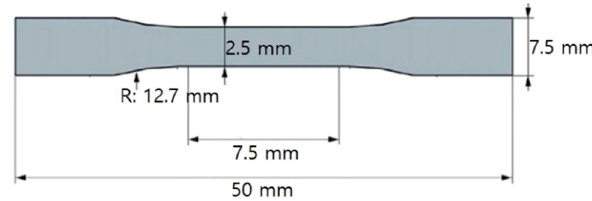
Figure 2: Speci fi cation of ASTM D638 tensile